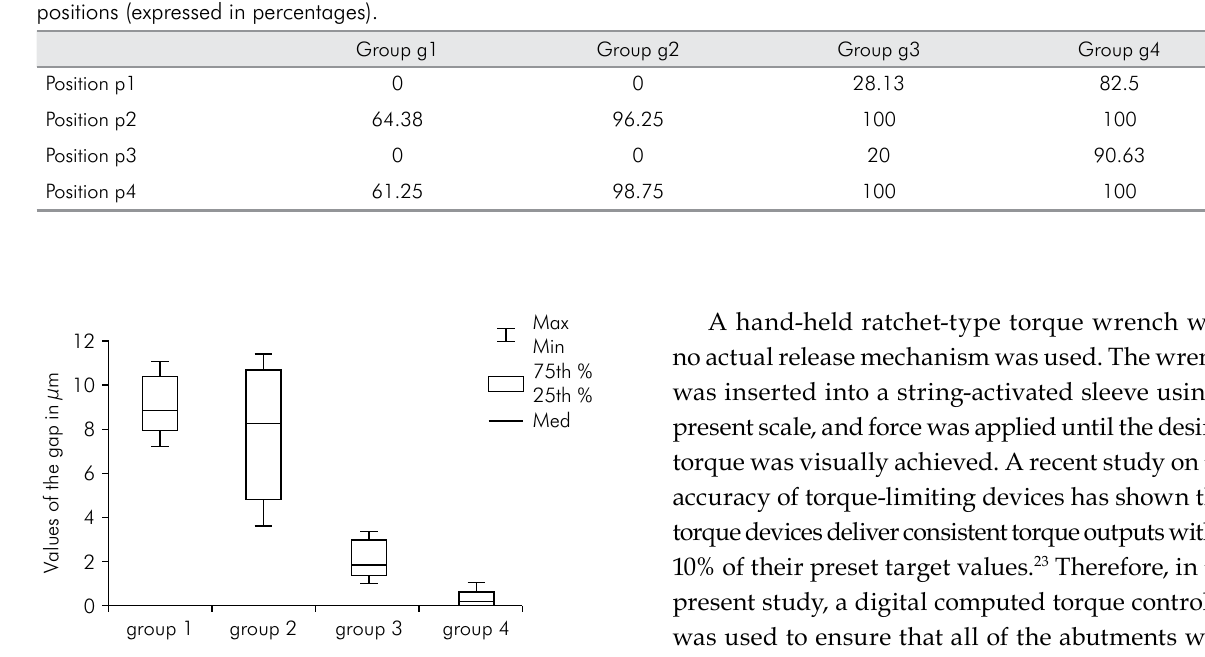
Figure 6. Boxplot of the overall mean gap for each group for the four positions (A, B, D and E).